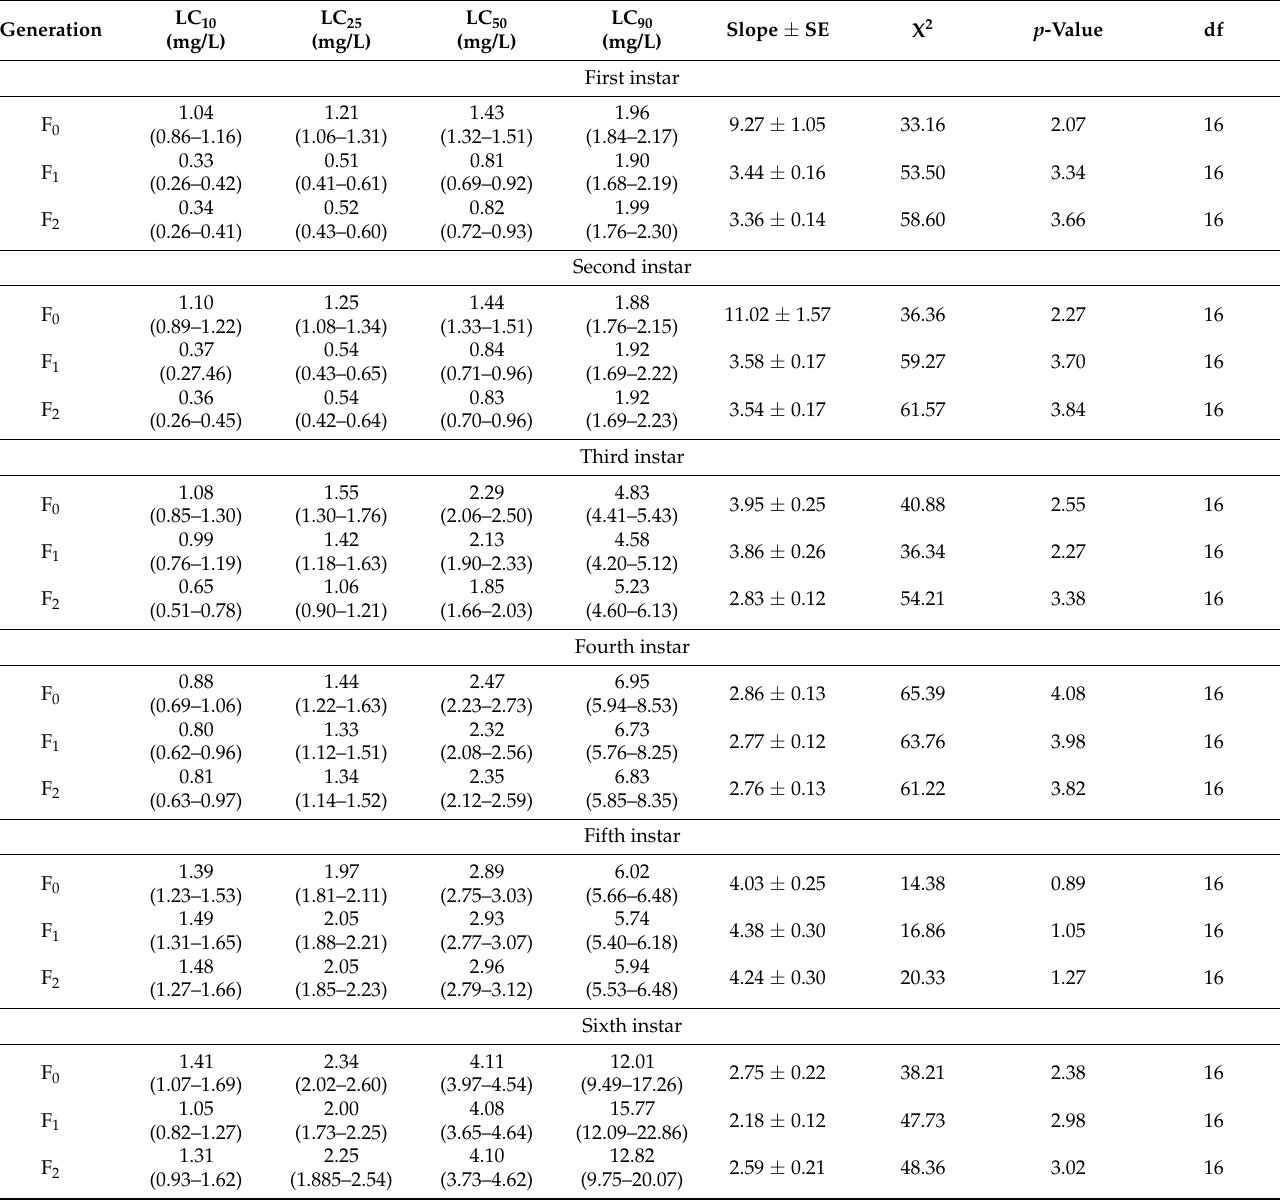
Table 1. Toxicity of chlorantraniliprole on six larval instars of the F 0 , F 1 and F 2 generations of Spodoptera frugiperda